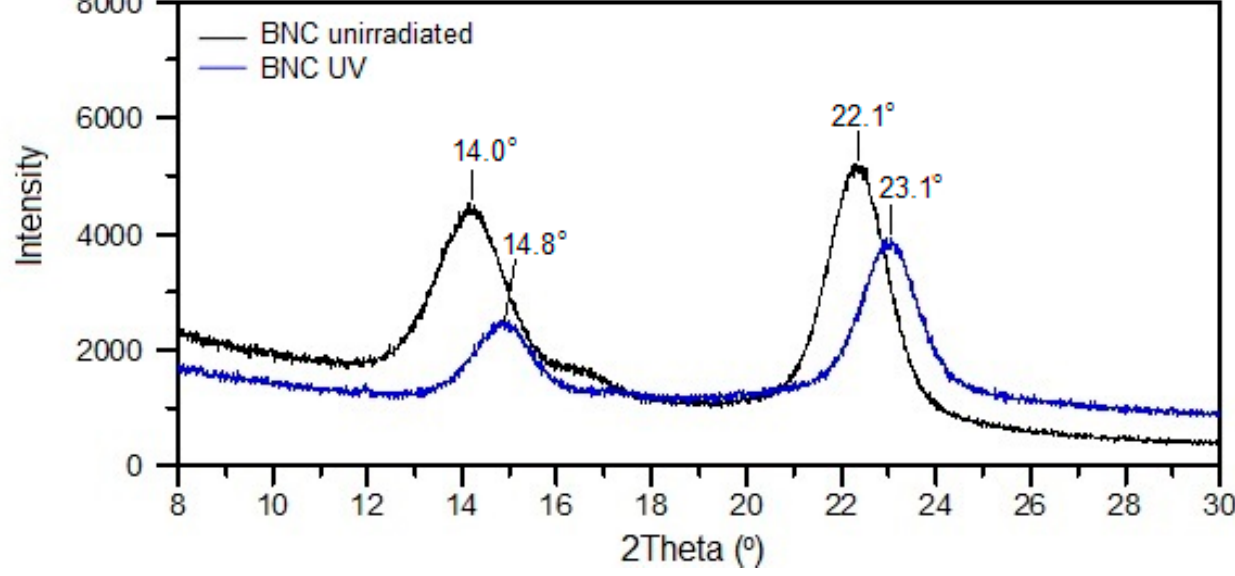
Figure 1. XRD patterns of BNC before and after 4 h of UV irradiation.